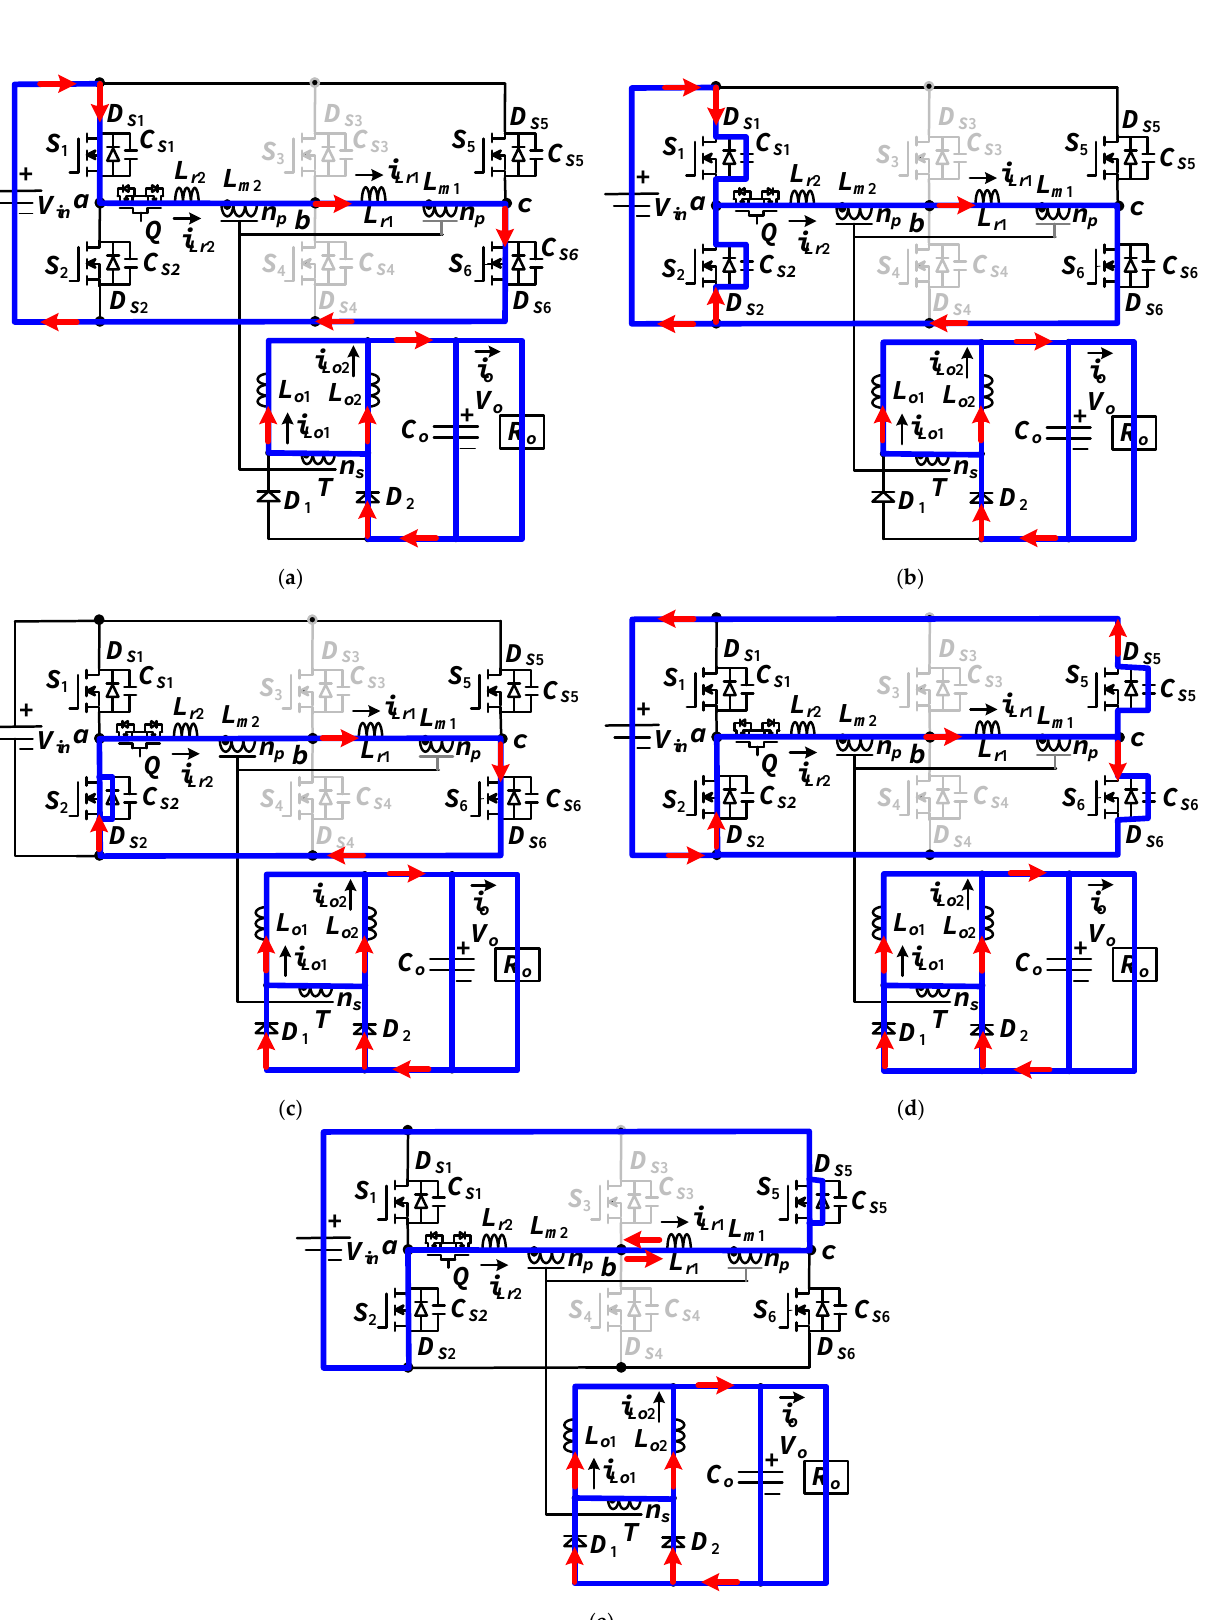
Figure 4. Equivalent circuits under high voltage input condition during the first half switching period: ( a ) step 1 circuit; ( b ) step 2 circuit; ( c ) step 3 circuit; ( d ) step 4 circuit;( e ) step 5 circuit.